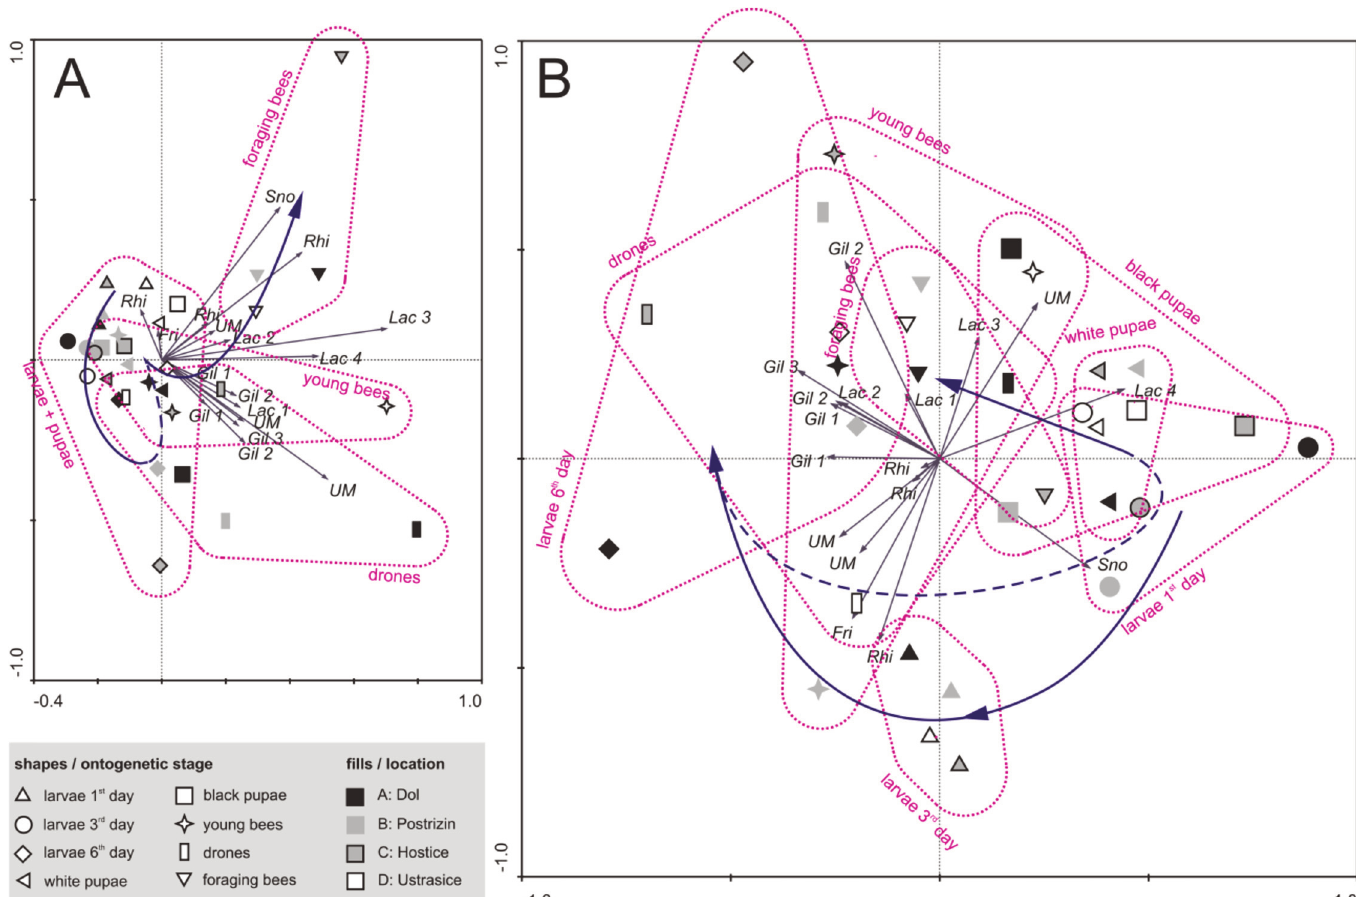
Fig 2. Biplot from redundancy analysis (RDA) explaining the distribution of honey bee ontogenetic stages according to major bacterial strain abundance. Test of interactions between factors location and ontogenetic stage: A, crude data considering absolute DGGE band intensities; B, centred and standardized data considering relative band intensities. Abbreviations: Gil, Gilliamella apicola ; Sno, Snodgrassella alvi ; Lac, Lactobacillus sp.; Rhi, Rhizobiales bacterium; Fri, Frischella perrara , UM, unknown multiple — probable DNA heterodimer. For further strain descriptions, see S5 Fig. Dotted shapes surrounding each ontogenetic stage were created as an aid in visualization. Eighteen bacterial strains occurring as major 16S rDNA DGGE bands were used for statistical analysis, while only selected strains are plotted as arrows. Same descriptions are for bands of the same sequence occurring at multiple locations of the line. Blue arrows show hypothetical developmental timeline. Its dotted part is